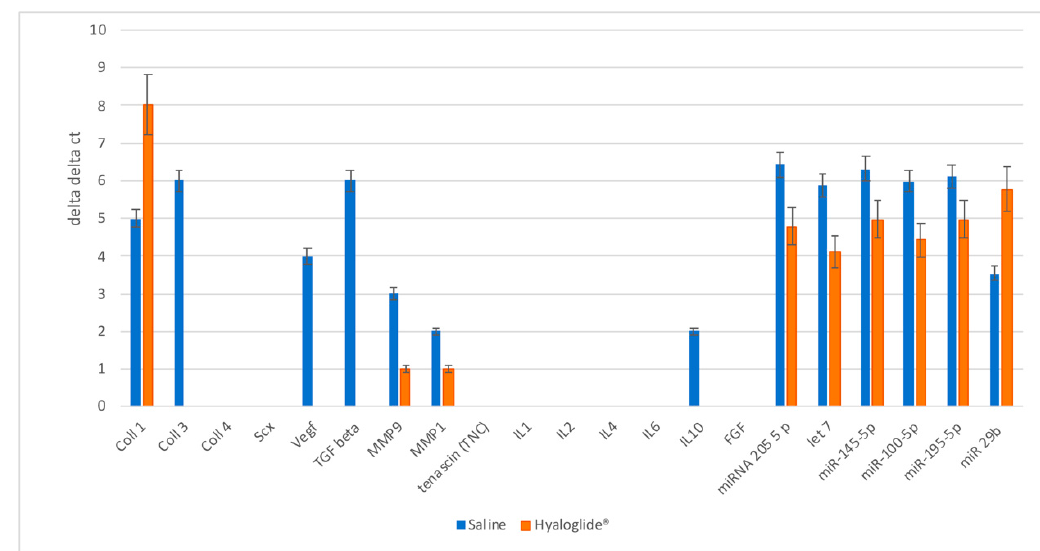
Figure 7. Real-time PCR analysis of proteins related to growth factors, miRNA, and enzymes involved in tendon regeneration and repair. The results for each experiment were obtained from triplicate experiments and values are expressed as the mean ± SD.